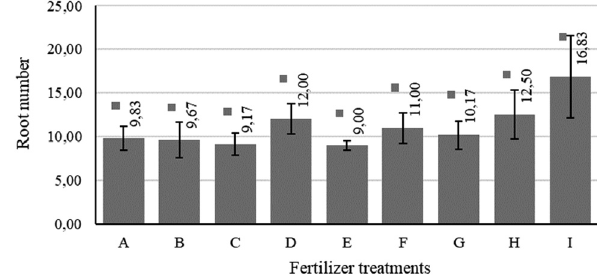
Figure 3: E ff ect of biofertilizer on root number of nutmeg seedlings at 24 weeks after transplanting in the greenhouse. A: control, B: 0.15% BB foliar spray, C: 0.15% BB soil application, D: